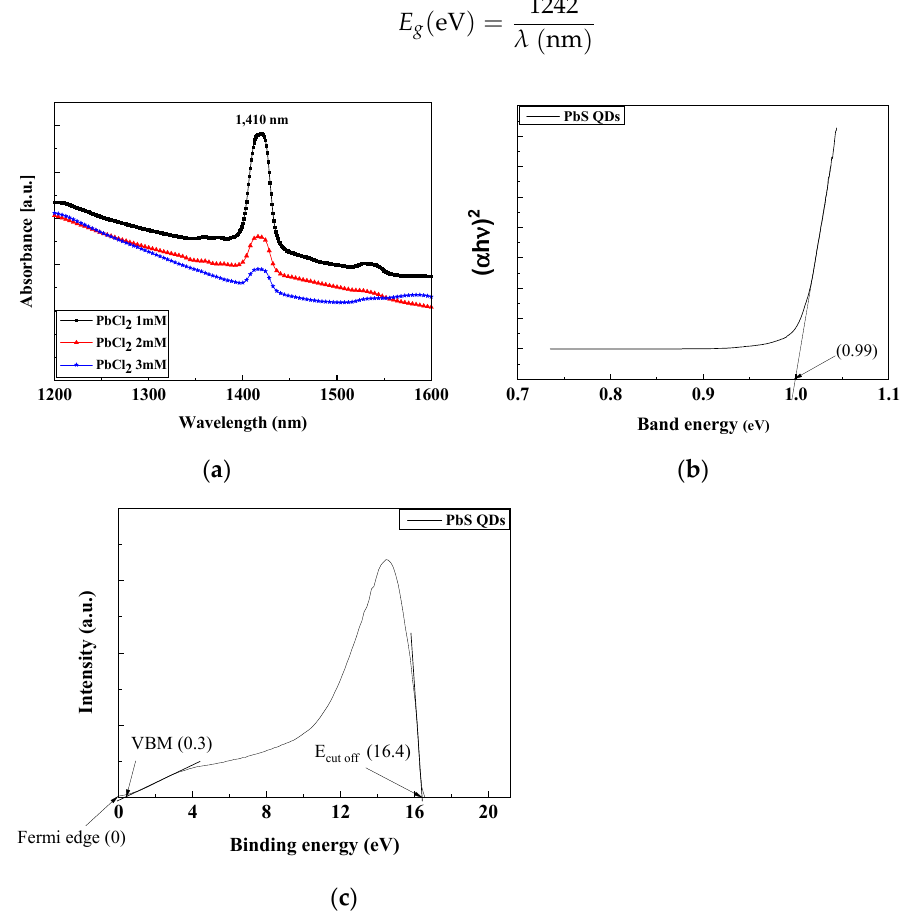
Figure 2. ( a ) Absorption property; ( b ) band gap energy; ( c ) UPS spectrum of the synthesized PbS QDs.